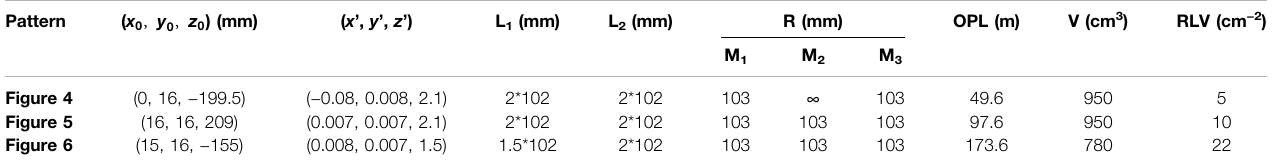
TABLE 1 | Incident location ( x 0 , y 0 , z 0 ), Incident vector ( x ’ , y ’ , z ’ ), Curvature radius (R) of three mirrors, M 2 , M 3 , Mirrors separated distance (L 1 ), (L 2 ), Volume (V) and Ratio (RLV) used to obtain the spot patterns depicted in Figures 4 , 9 .